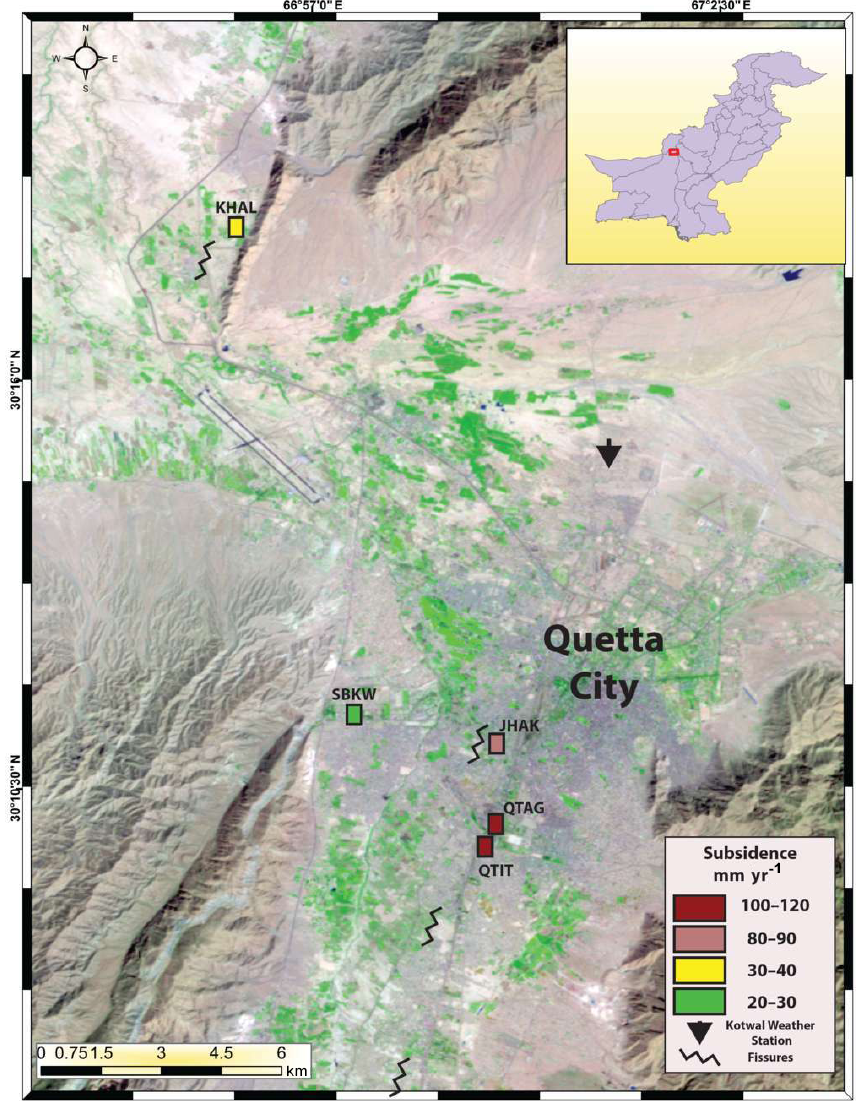
Figure 4. Map showing subsidence in the Quetta valley. The dark brown color is showing subsidence of 100–120mmyr − 1 , the light brown color is showing subsidence of 80–90mmyr − 1 , the yellow color is showing subsidence of 30–40mmyr − 1 , the green color is showing subsidence of 20–30mmyr − 1 . The fissures can also be seen on the map whereas the Kotwal Weather station is shown by a black arrow. 30m Digital Elevation Model (DEM) of Shuttle Radar Topographic Mission (SRTM) were downloaded from ©NASA’s Earth Explorer website to identify the topography and profile of the study